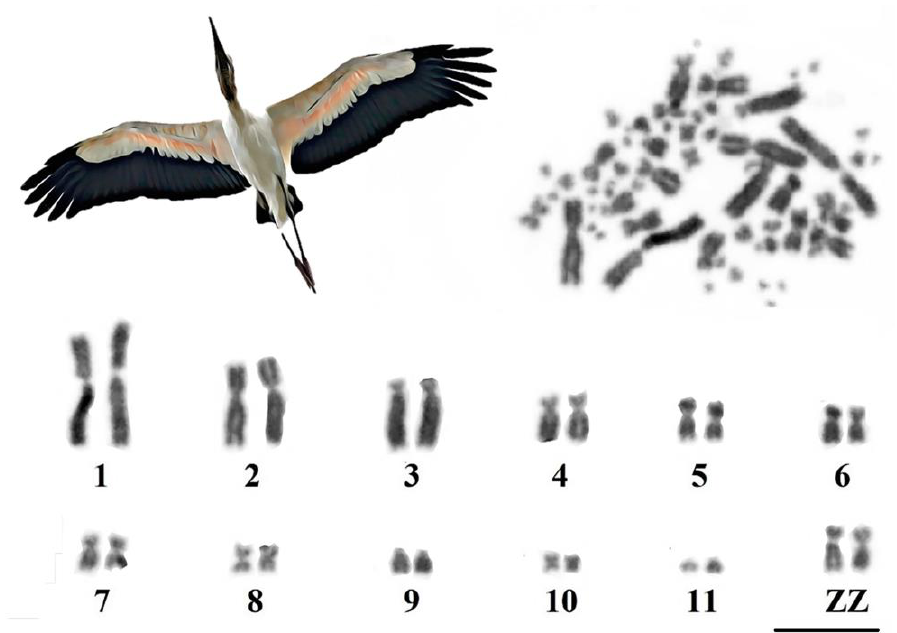
Figure 1. Photomicrograph of a spread of a male M. americana in conventional staining (top) and partial karyotype (bottom) with macrochromosomes arranged according to their size (bar = 10µm). C-banding revealed blocks of constitutive heterochromatin distributed and restricted to the pericentromeric region of macrochromosomes and some microchromosome pairs (Figure 2).